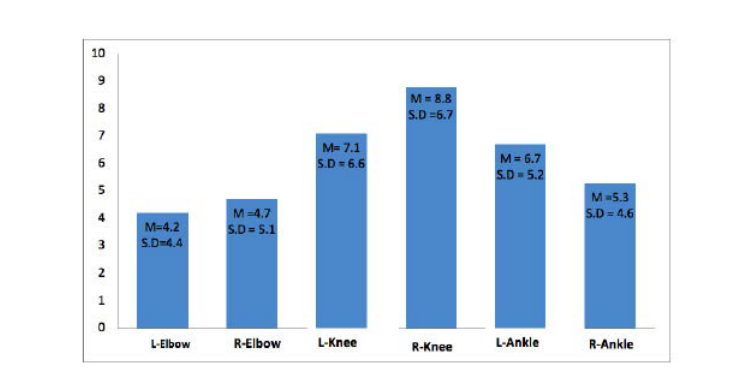
Figure 2. Average joint score of patients’ hinged joints. L: Left, R: